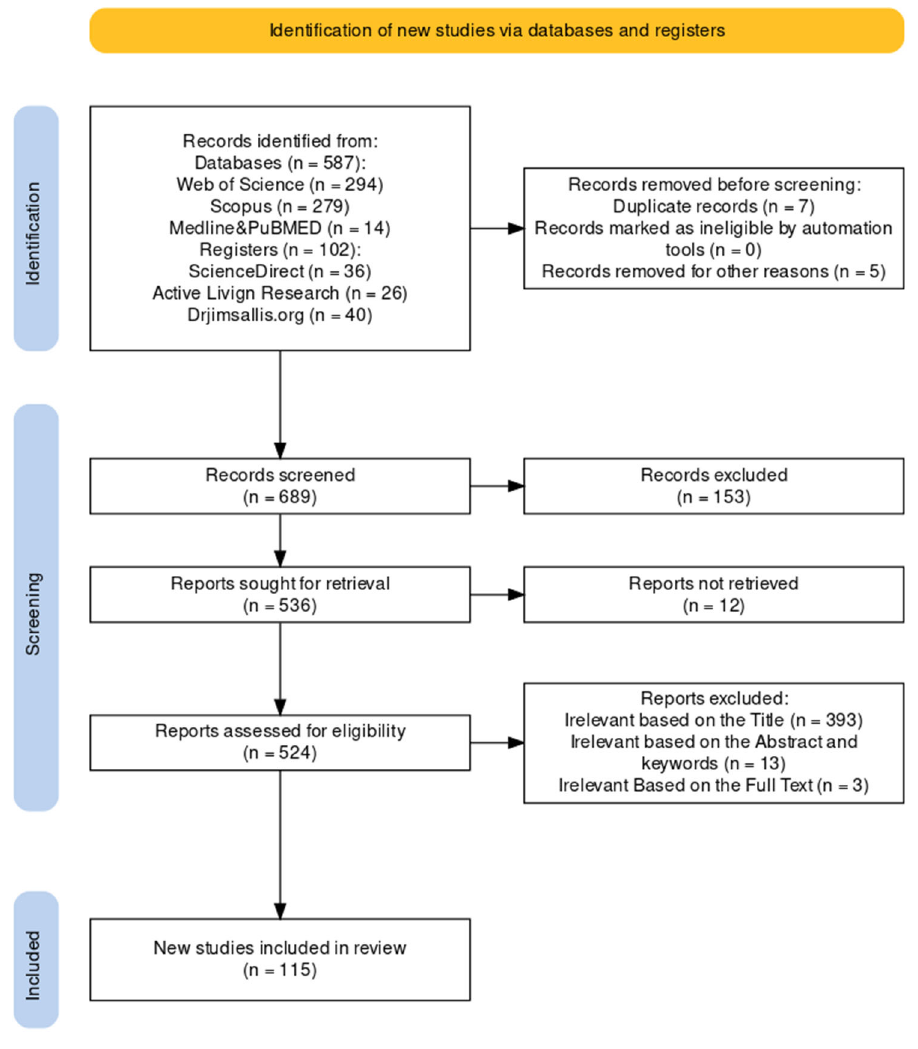
Figure 3. Flowchart of the literature review process.